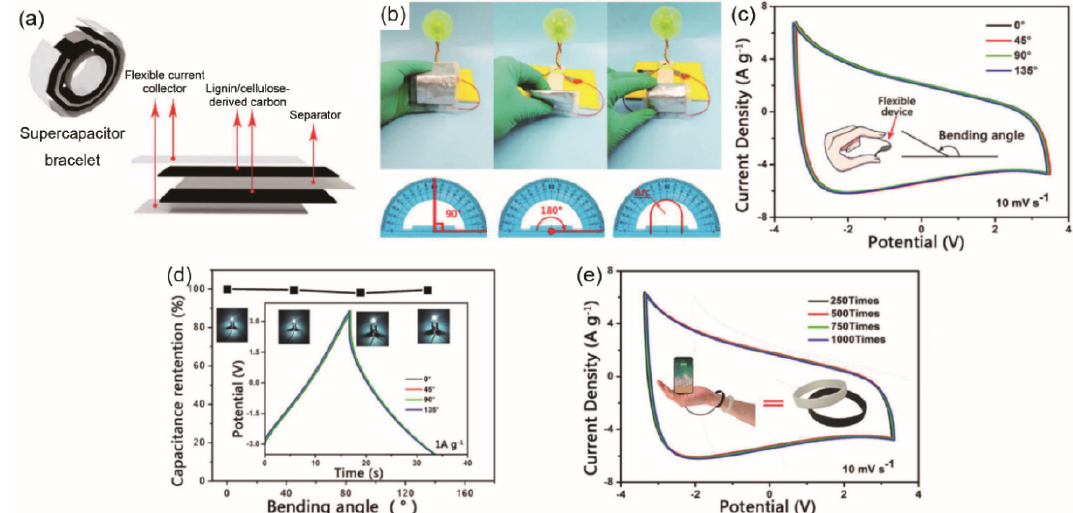
Figure 11. The EC performance of cellulose acetate-based flexible SC at different bending angles. ( a ) Schematic illustration of the flexible supercapacitor. ( b ) The small fan powered by the flexible supercapacitor at different bending angles. ( c ) CV curves under 10 mV/s. The inset depicts a bending angle. ( d ) Capacitance retentions and the corresponding bulb brightness. The inset shows the galvanostatic charge/discharge (GCD) curves at 1 A/g. ( e ) CV cycle test at 10 mV/s. The inset shows a supercapacitor wristband. ( a – e ) Reproduced with permission from ref. [199] Copyright 2019 John Wiley and Sons.